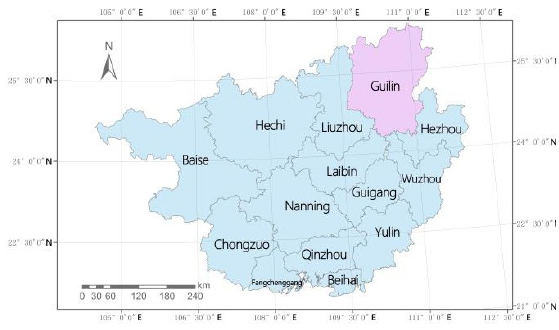
Figure 2-1 geographical location of Guilin city The downtown area of Guilin is located in the central part of Guilin city, on the Lijiang river valley basin, and distributed in a ribbon on the upper Banks of the Lijiang river in the north- south direction. It has jurisdiction over 12 counties and the urban area of Guilin, with a total area of 27,809 square